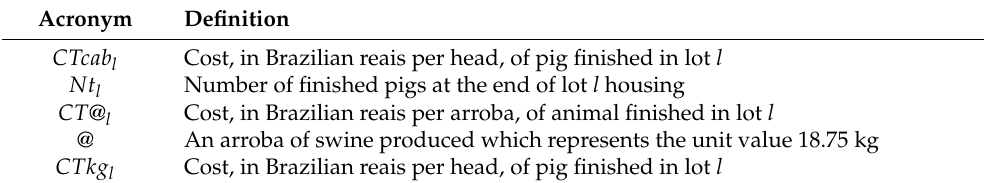
Table 9. Acronyms and definitions of formulas used to calculate the total cost that compose the calculation model for swine